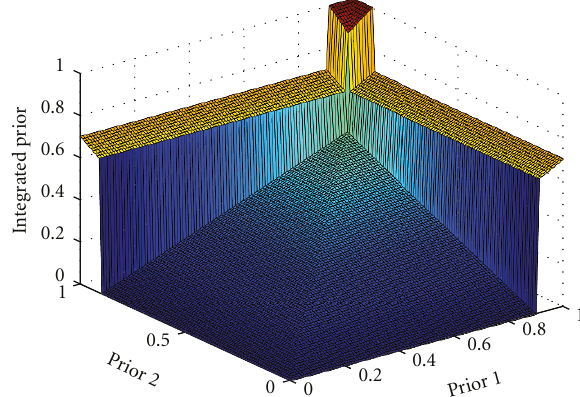
Figure 2: An illustration of the prior integration method. An illustration of the prior integration method for the case of two additional data sources. x and y axes correspond to the two data sources and z -axis corresponds to the integrated